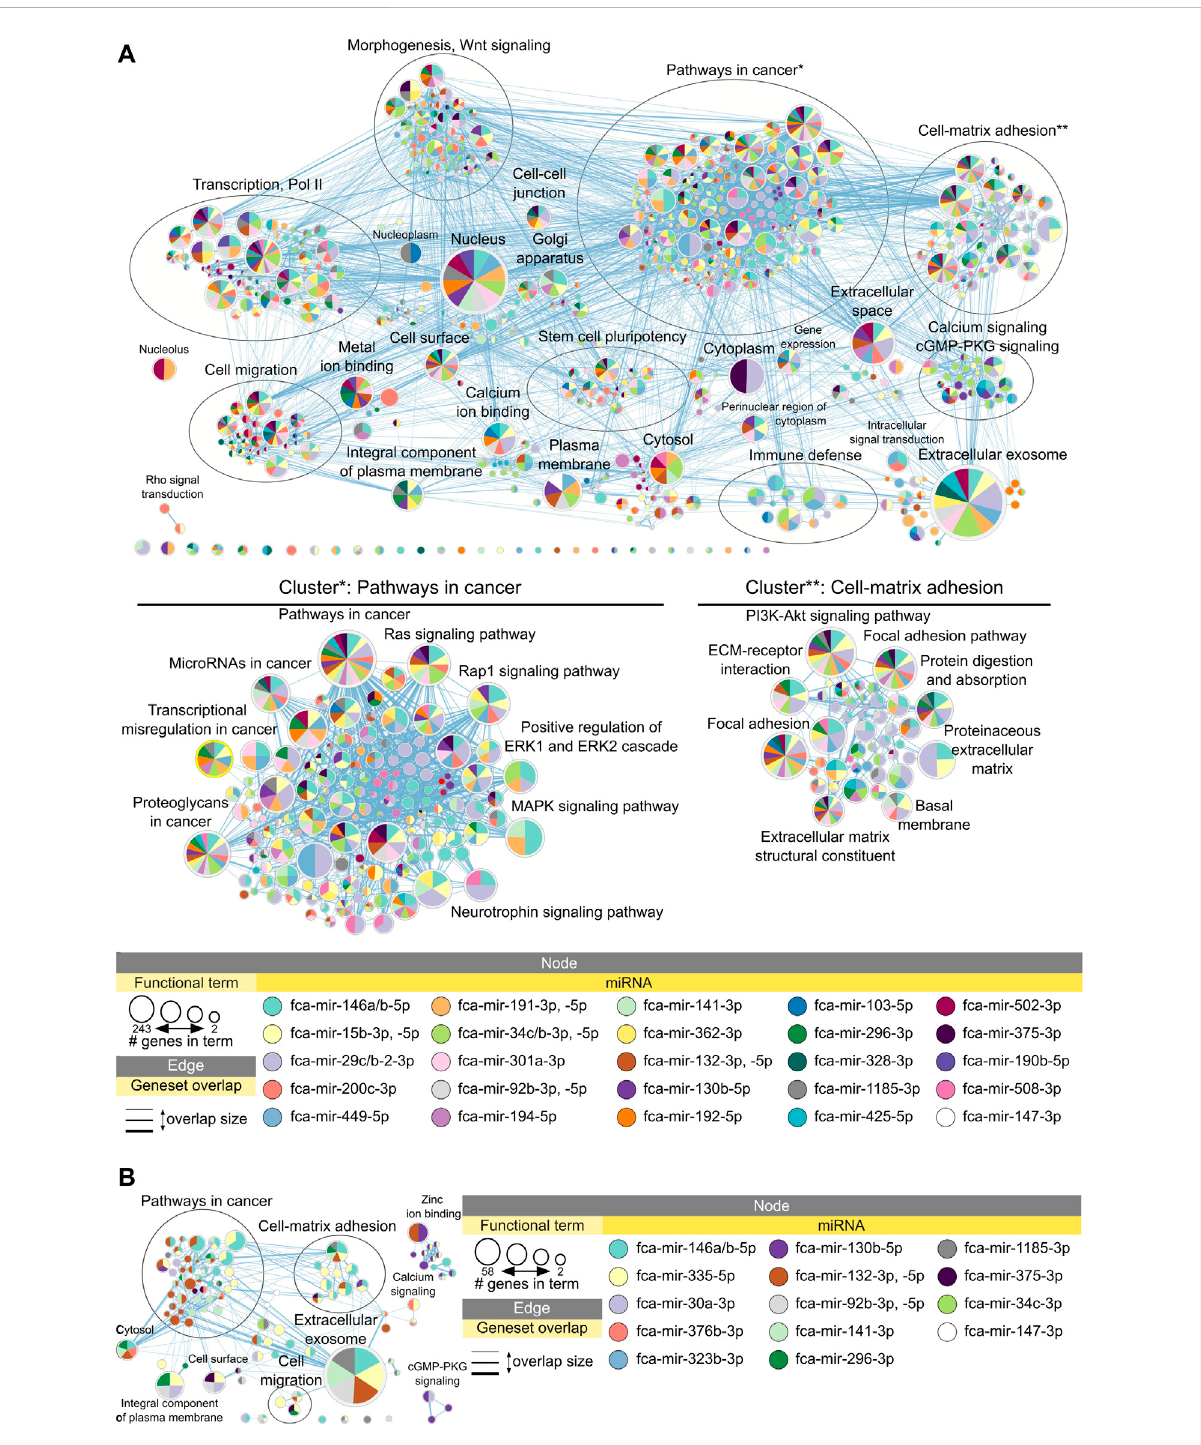
FIGURE 4 Functional terms and pathways potentially inhibited by miRNAs in adult testes. Enrichment map displays enriched gene-sets based on downregulated mRNA targets for each upregulated miRNA in (A) adult vs. early juvenile testis, i.e., enriched in earl juvenile, and (B) adult vs. late juvenile testis, i.e., enriched in late juvenile. Interactive networks including networks of each functional cluster with corresponding data tables are available in Supplementary Data Sheet